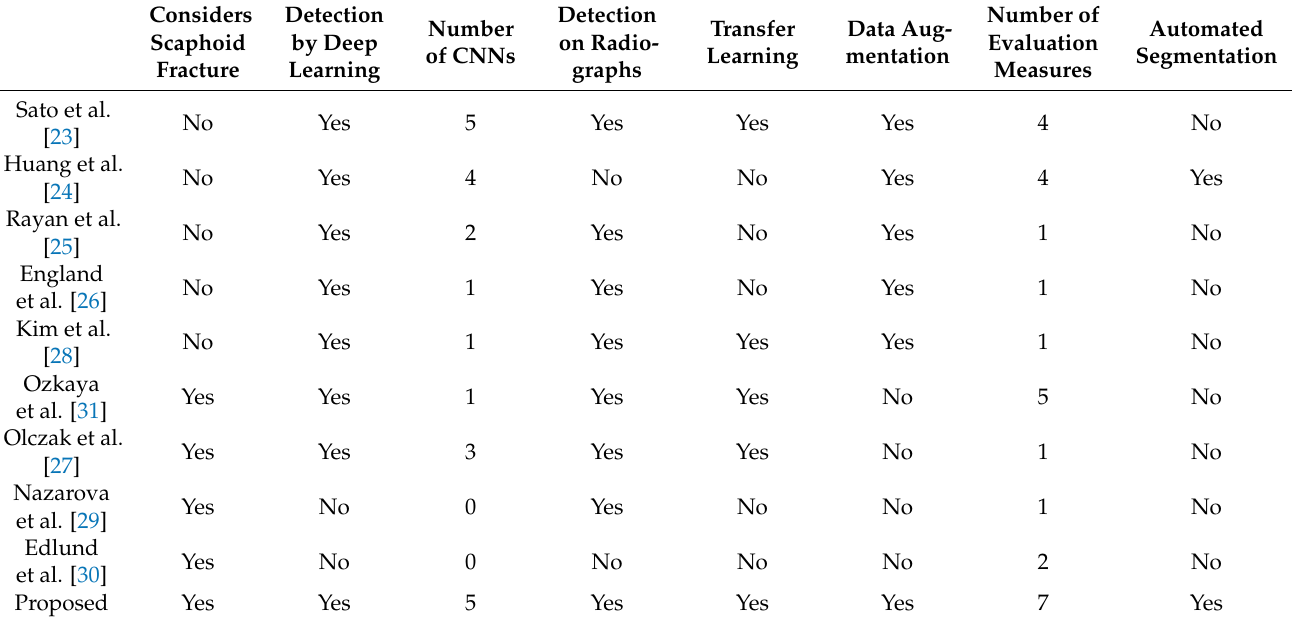
Table 1. Comparison of proposed work and related works.